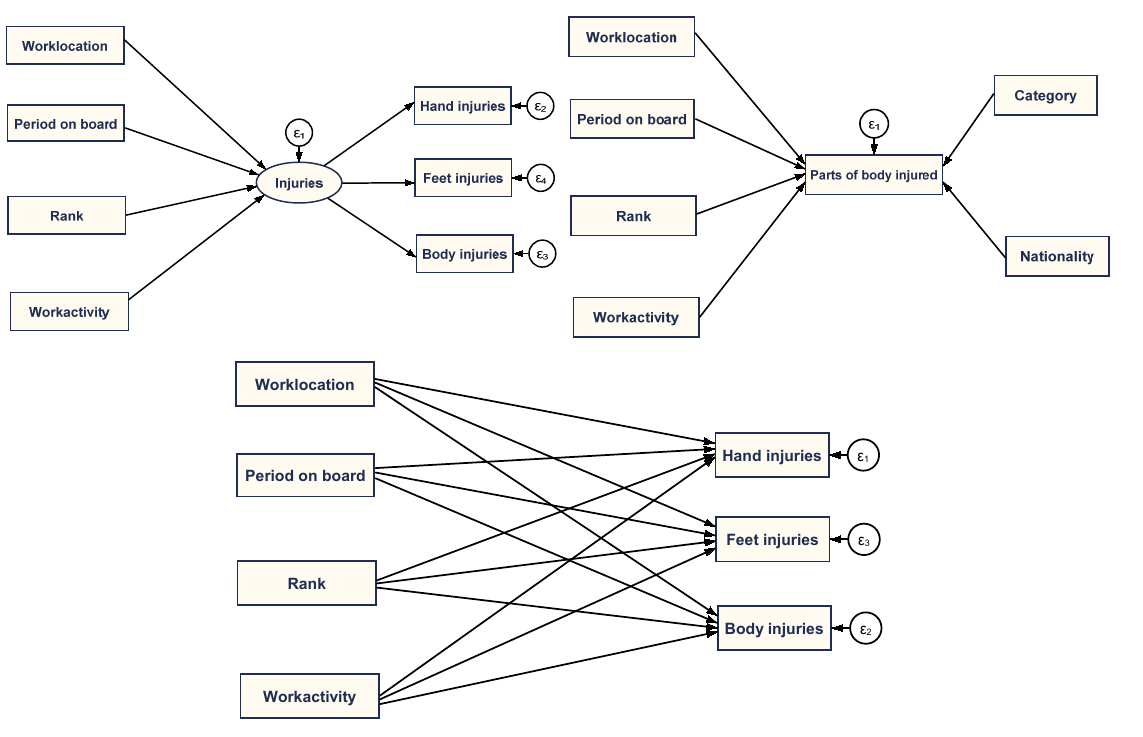
Figure 4. General configuration of the structural equation models. Source: Authors’ research.